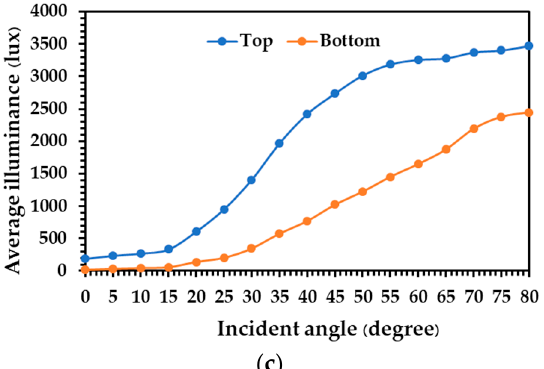
Figure 8. Average illuminance at the top and bottom tube position of zinc alloy tube with diameters of ( a ) 0.20 m, ( b ) 0.25 m, and ( c ) 0.30 m.